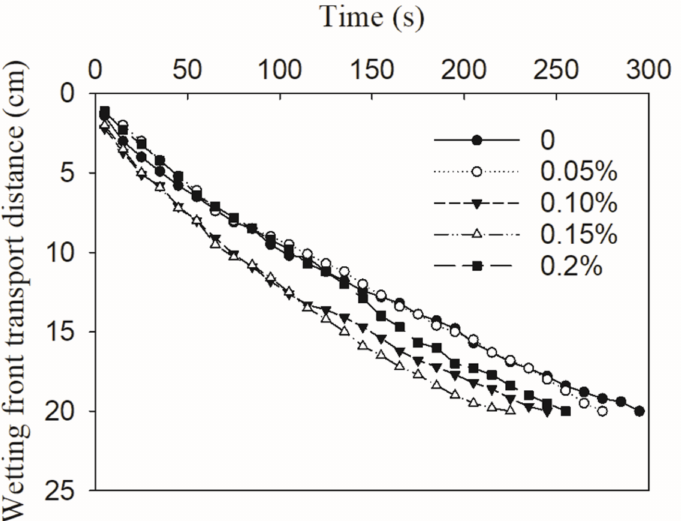
Figure 3. Variation characteristics of migration distance of complex soil wetting front under different BM addition ratios. The percentage represents the mass ratio of BM added.